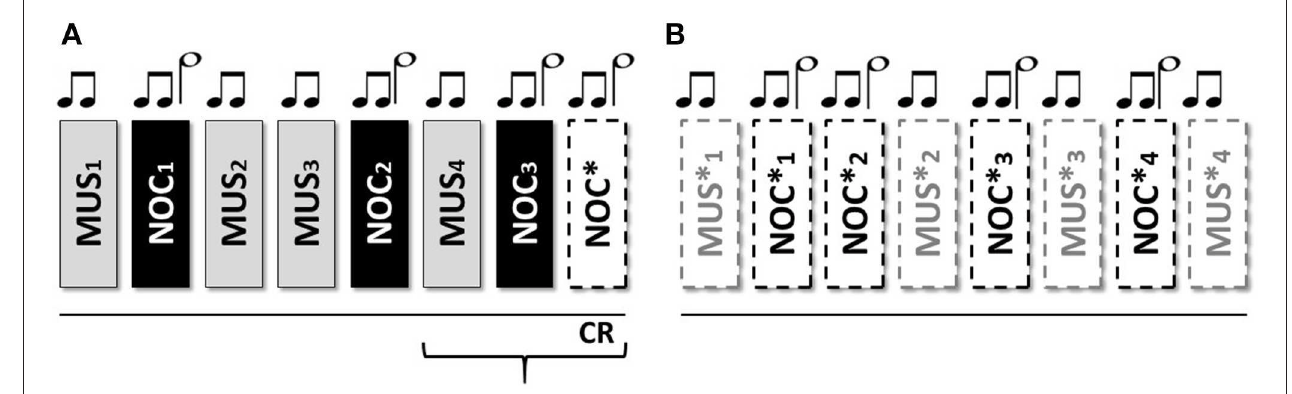
FIGURE 1 | Sequence of the stimuli: two short grave notes anticipate the musical stimulus; two short grave notes and one long acute note at an interval of 5th anticipate the noxious stimulus. From Sequence (A) 1 to 7 the stimuli were associated to the tones; the eighth without stimulus administration to verify the CR; Sequence (B) from 9 to 16 only tones for the extinction of the